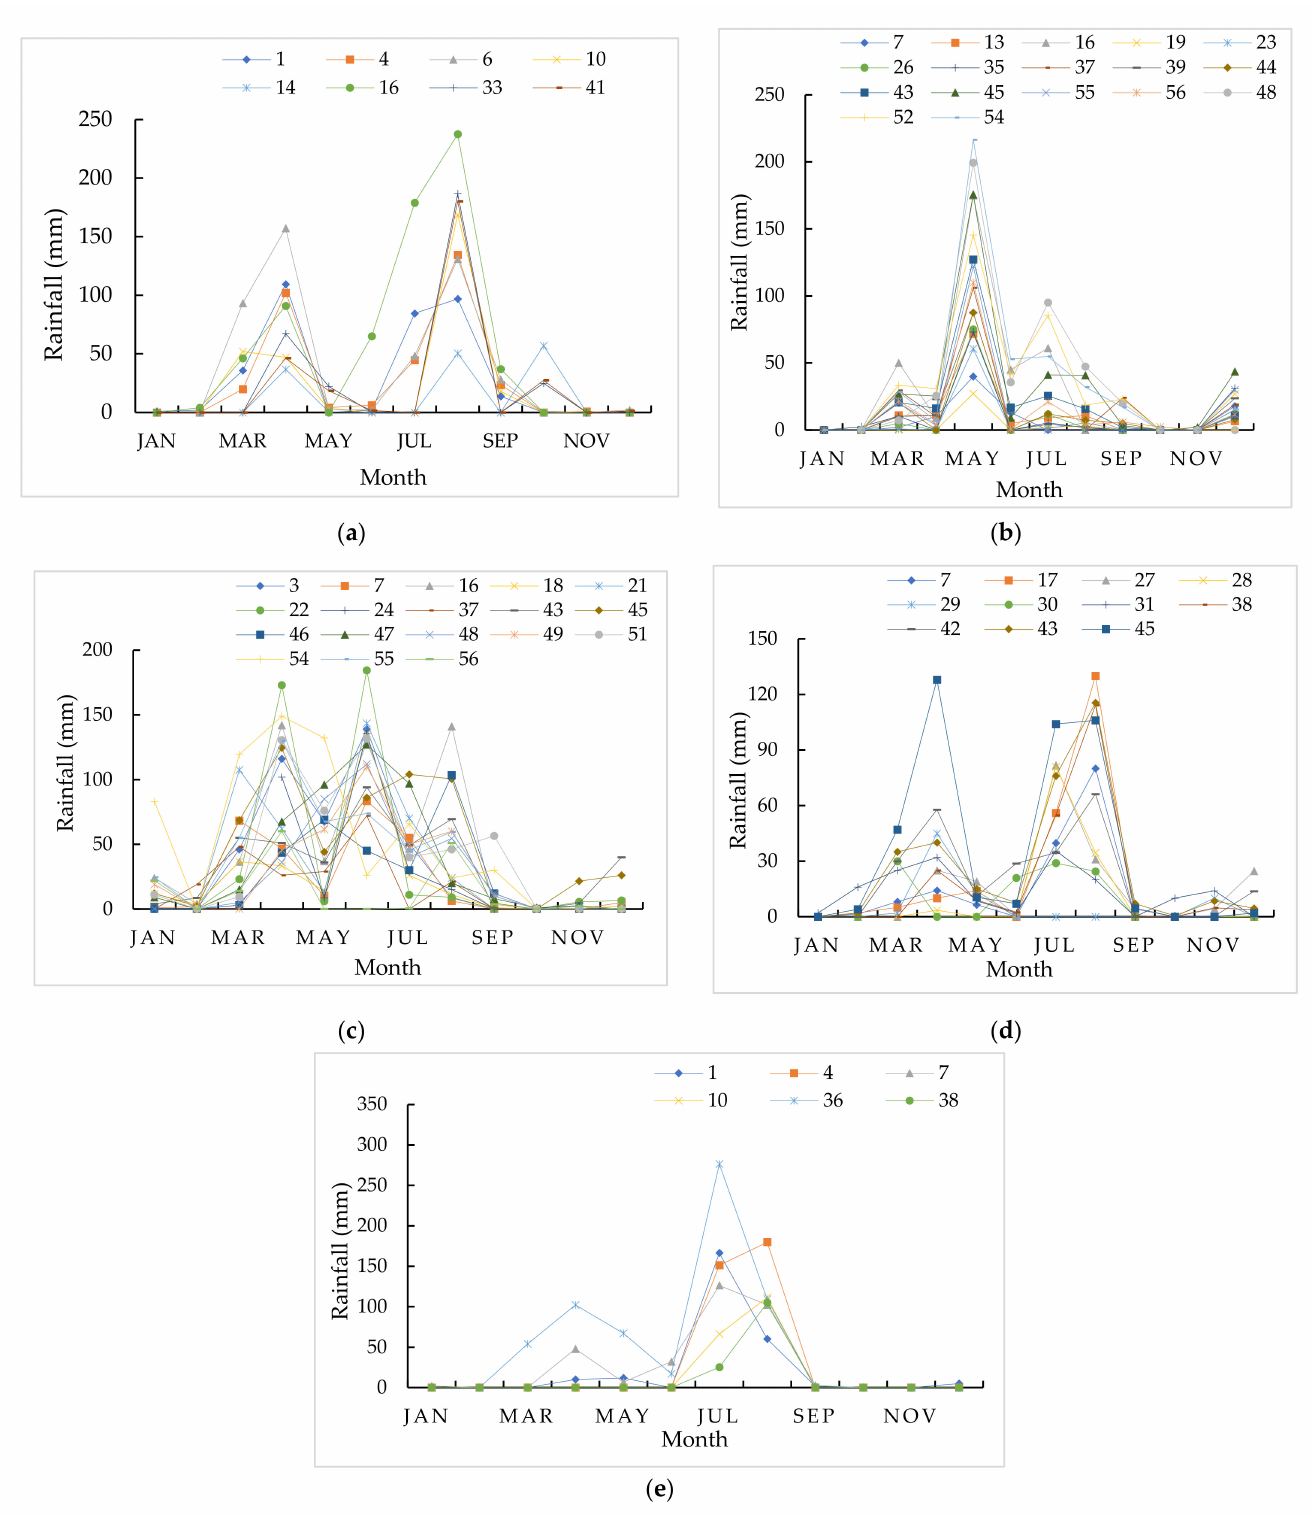
Figure 3. Rainfall records for the stations in some selected years: ( a ) 1975; ( b ) 1984; ( c ) 1996; ( d ) 2006; ( e ) 2020 (numbers in the legend refer to rainfall recorded station